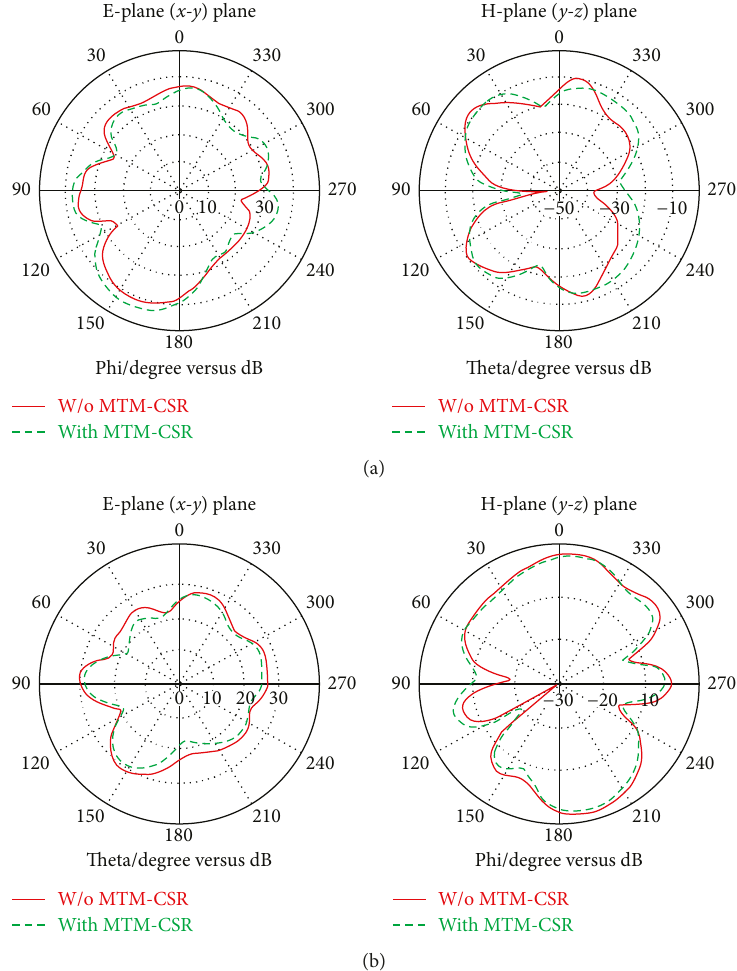
Figure 24: The radiation pattern of the E-shaped MIMO antenna system in the orthogonal con fi guration: (a) E-plane and H-plane for the left and (b) E-plane and H-plane for the right E-shaped